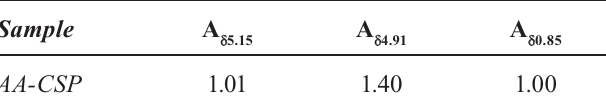
TABLE I - Peak area of δ 5.15, δ 4.91, δ 0.85 1H NMR